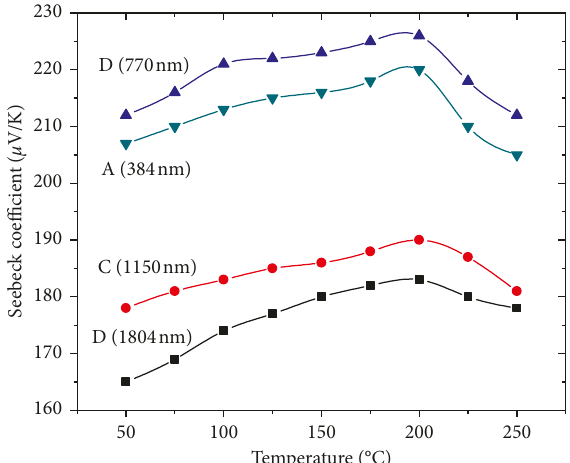
Figure 3: Variation in Seebeck coefficient as a function of tem- perature for Sb 2 Te 3 films of different thicknesses.